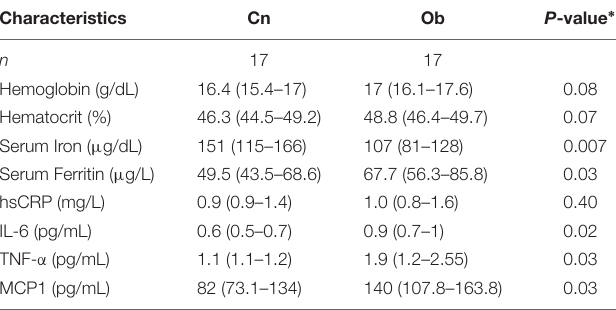
( Figure 1C ) between Ob and Cn ( p = 0.018; p = 0.019 and p = 0.02, respectively).